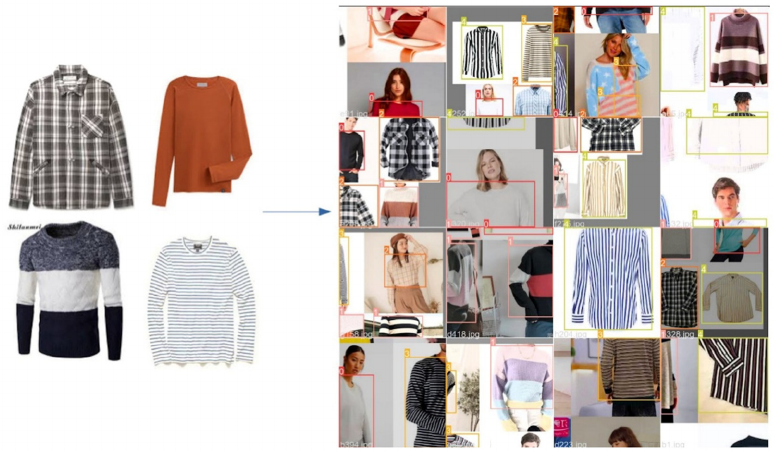
Figure 10. Mosaic image augmentation.